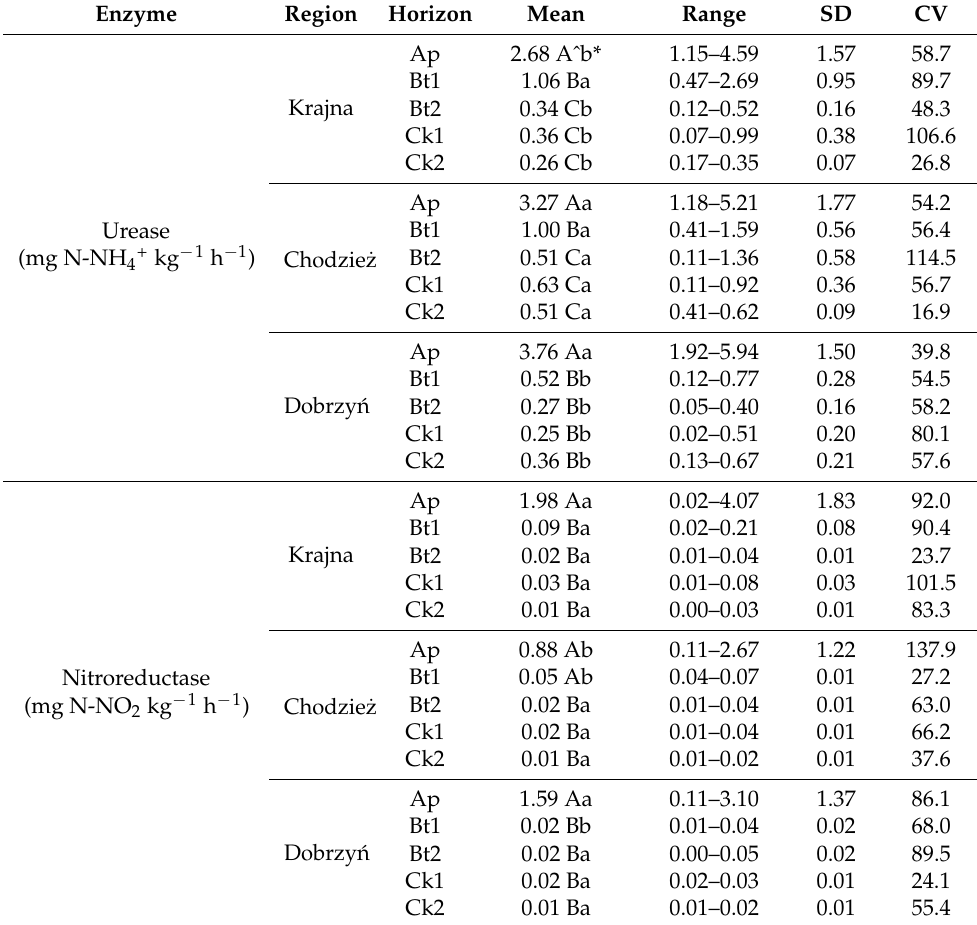
Table 3. Basic statistics of N-related enzymatic